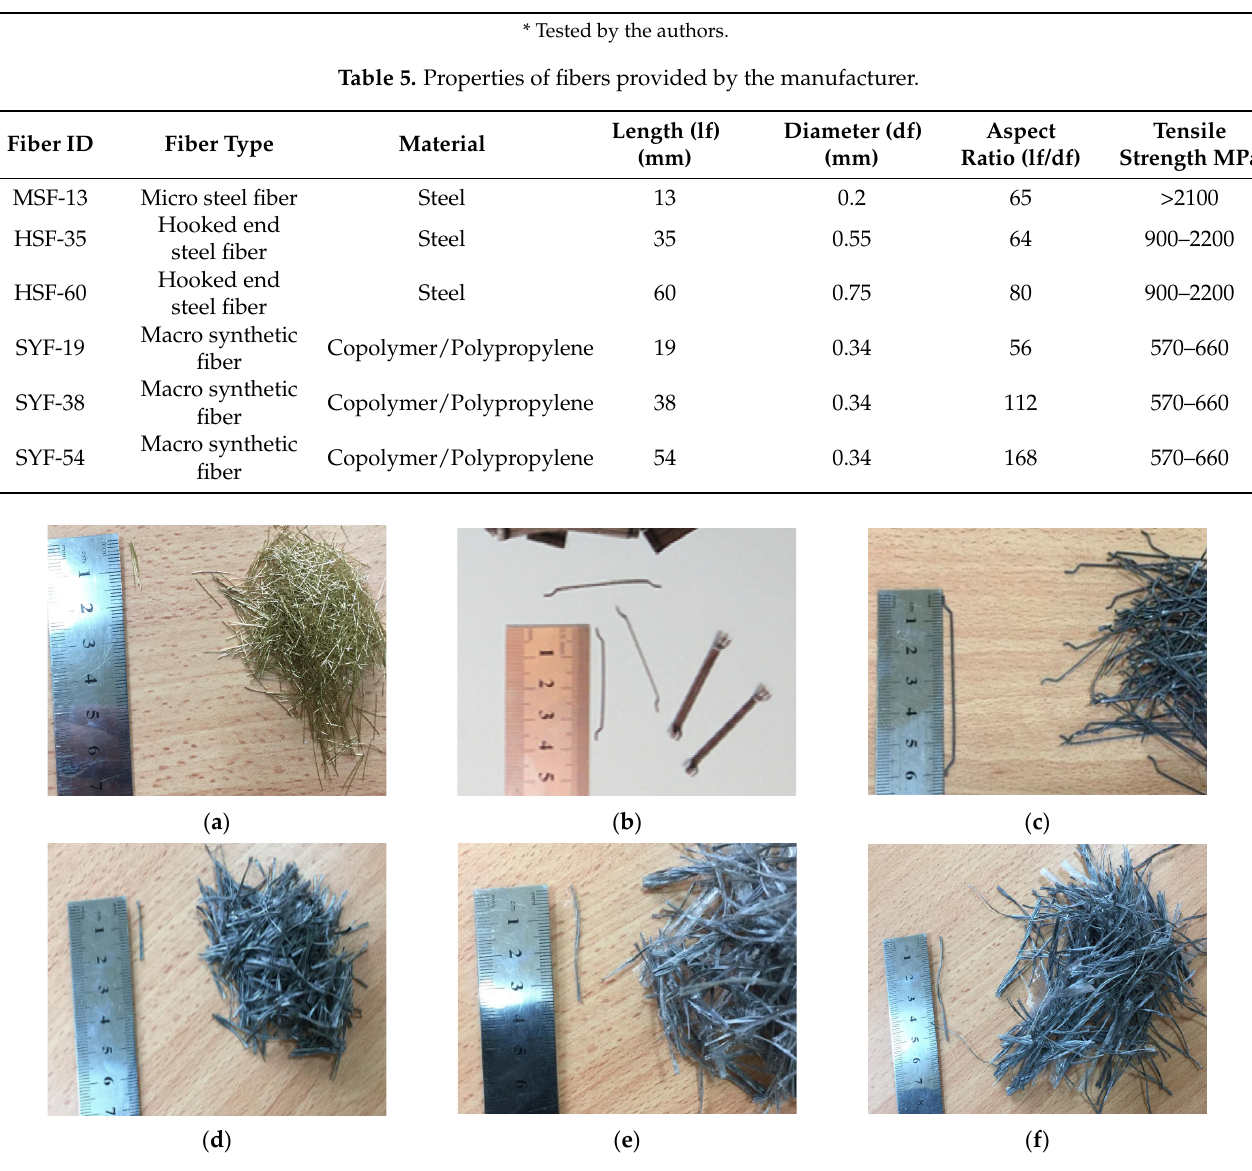
Figure 1. ( a ) MSF ‐ 13, ( b ) HSF ‐ 35, ( c ) HSF ‐ 60, ( d ) SYF ‐ 19, ( e ) SYF ‐ 38, and ( f ) SYF ‐ 54 fibers. Figure 1. ( a ) MSF-13, ( b ) HSF-35, ( c ) HSF-60, ( d ) SYF-19, ( e ) SYF-38, and ( f ) SYF-54